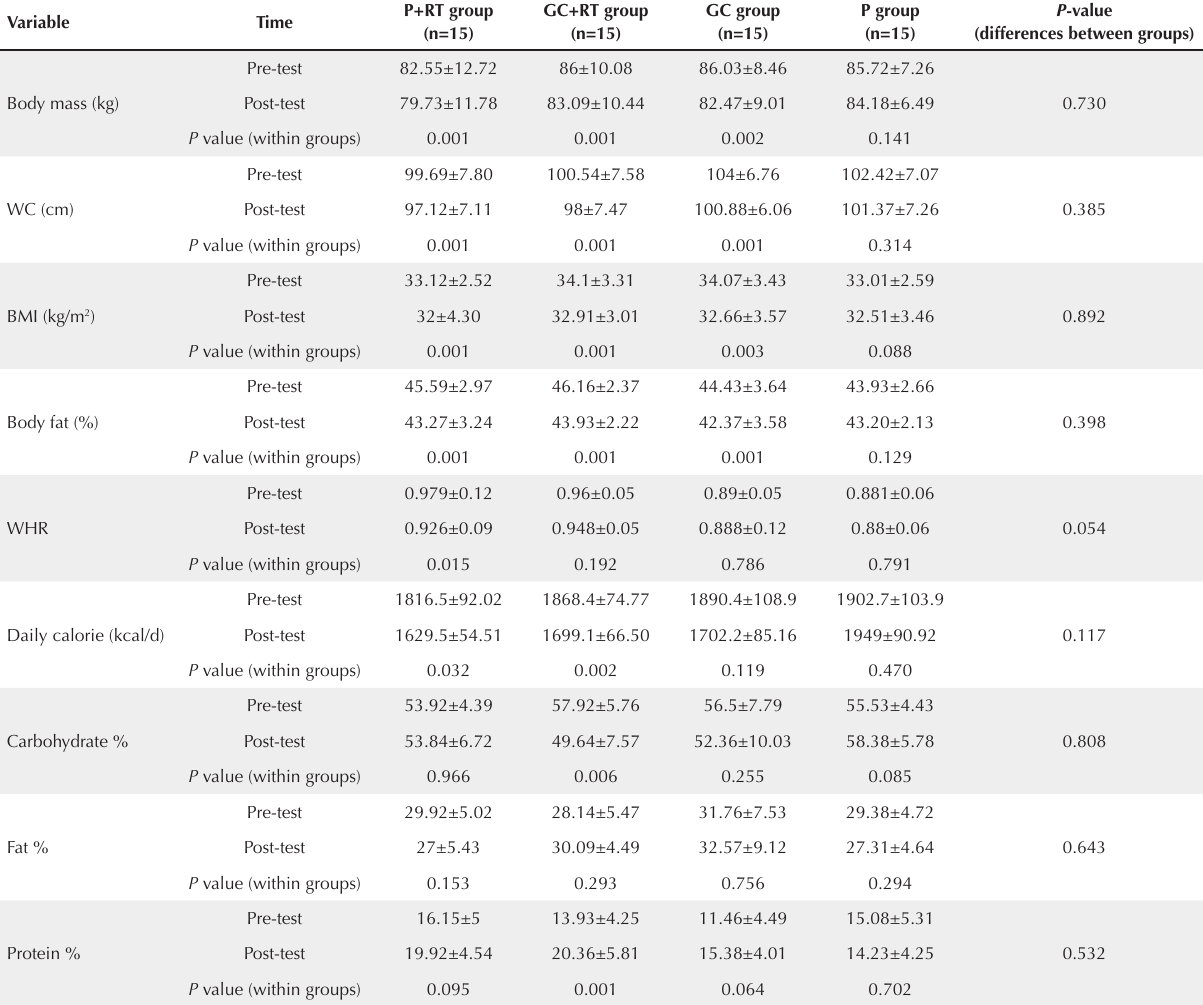
Table 2. Comparison of Body Composition between Groups after 8 Weeks of Intervention